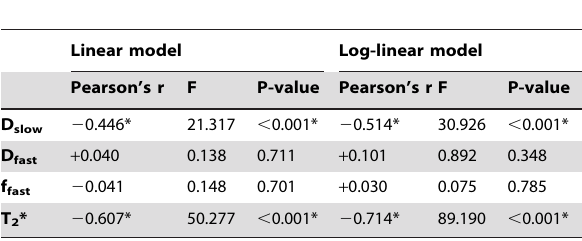
correlation (r = 2 0.767 to 2 0.804; p # 0.048) was observed between HFF and T 2 * using the log-linear model (Table 4). Discussion Effect of fat on IVIM-DWI parameters In this study it was demonstrated that molecular diffusion (D slow ) in the liver is affected by hepatic fat, also in the absence of steatosis (HFF below 5.5%). D slow differed significantly between three groups of different HFF, and a steady significant decrease of D slow with moderate correlation was found for increasing HFF. These results complement existing knowledge of the reduction of molecular diffusion by steatotic HFF ( . 5.5%). Previous IVIM studies showed comparable negative correlations (r = 2 0.59 and r= 2 0.18) between HFF and molecular diffusion using a linear Table 2. Correlations of IVIM-DWI parameters and T 2 * with hepatic fat fraction (HFF) using two models.